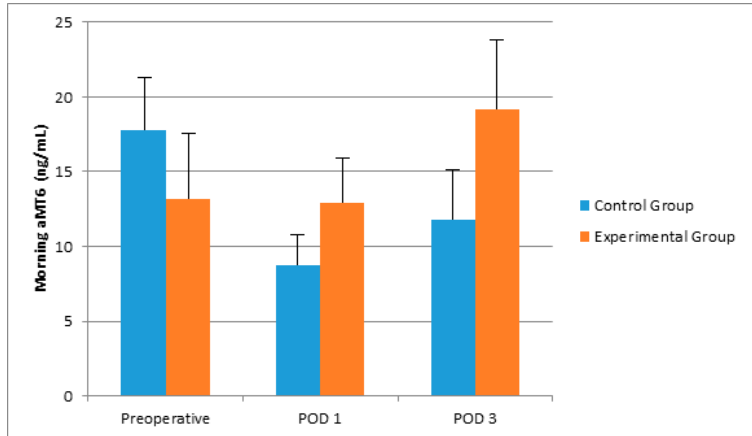
Figure 3. The effects of controlling noise and light in ICU on morning aMT6 levels after major abdominal surgery.